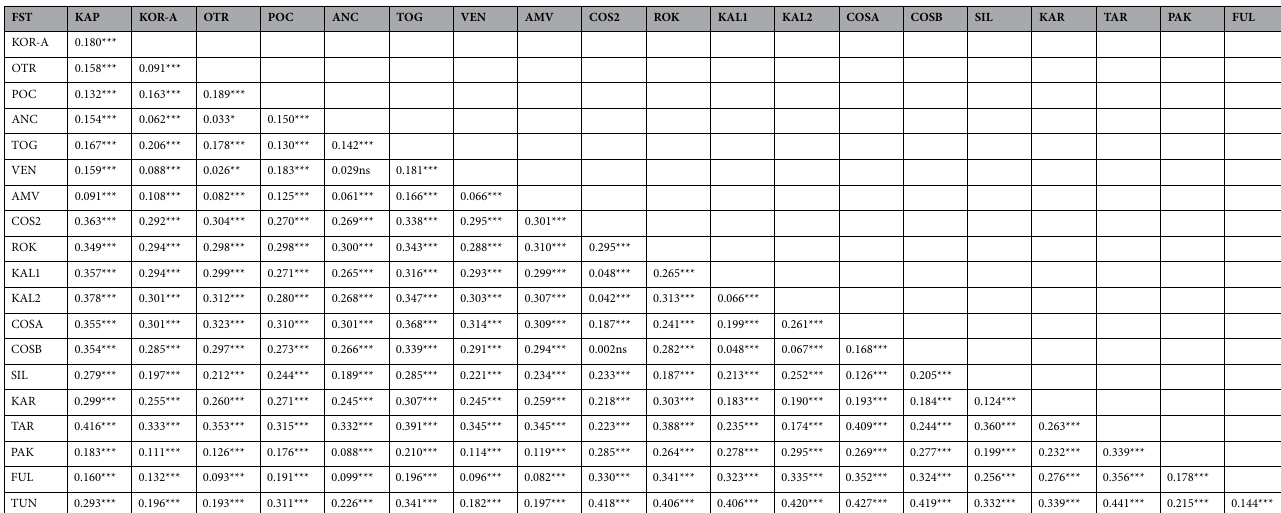
Table 3. Pairwise F st comparison of the 20 Tritia neritea samples. Significance of values are given as follows: ns = non-significant, ***< 0.001; **< 0.01; *<